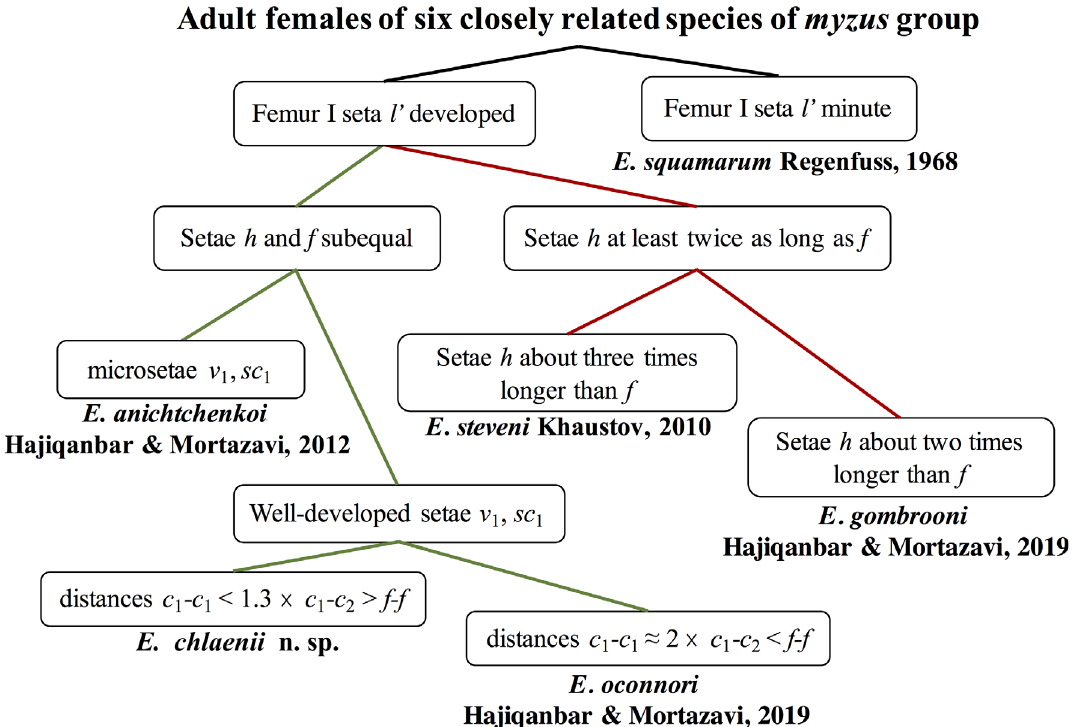
Figure 12. Key to closely related species of myzus group (based on adult females) possessing similar characters including short cheliceral stylets (<35 l m